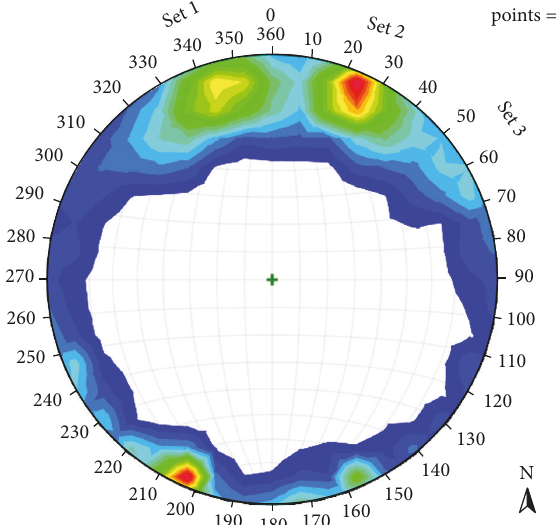
Figure 2: Orientation data (lower hemisphere, equal-area projec- tion of poles to planes) of all joint sets measured by the two surveys carried out at different scales.